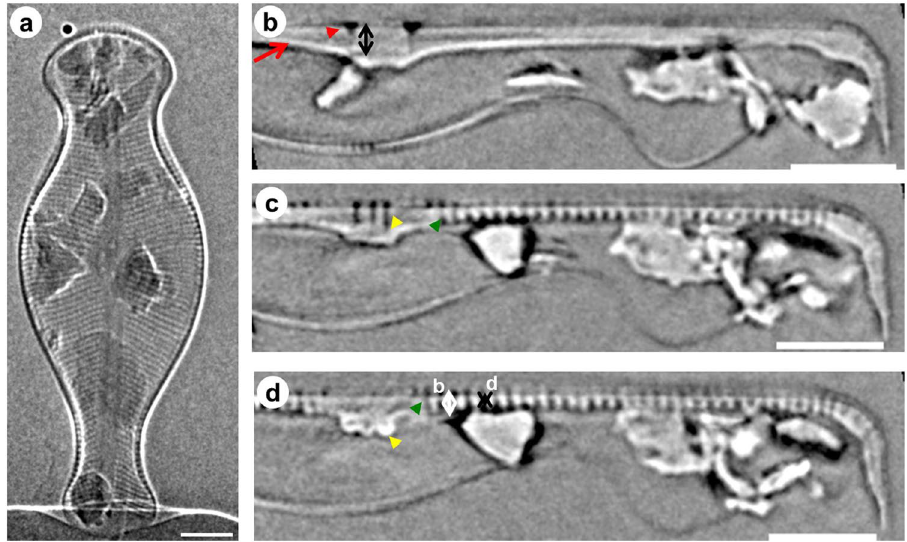
Figure 2. Nano–XCT results of the frustule of D. geminata . ( a ) One projection of the entire frustule of D. geminata imaged by nano–XCT in phase contrast mode. ( b – d ) One slice extracted from the reconstructed 3D volume in girdle view of the frustule. Red arrowheads : raphe, red arrow : raphe extending, green arrowheads : ribs, yellow arrowheads : stigmata, white and double arrows : width, height, and distance of the ribs and struts. Scale bars: 10 µ m ( a – d ).